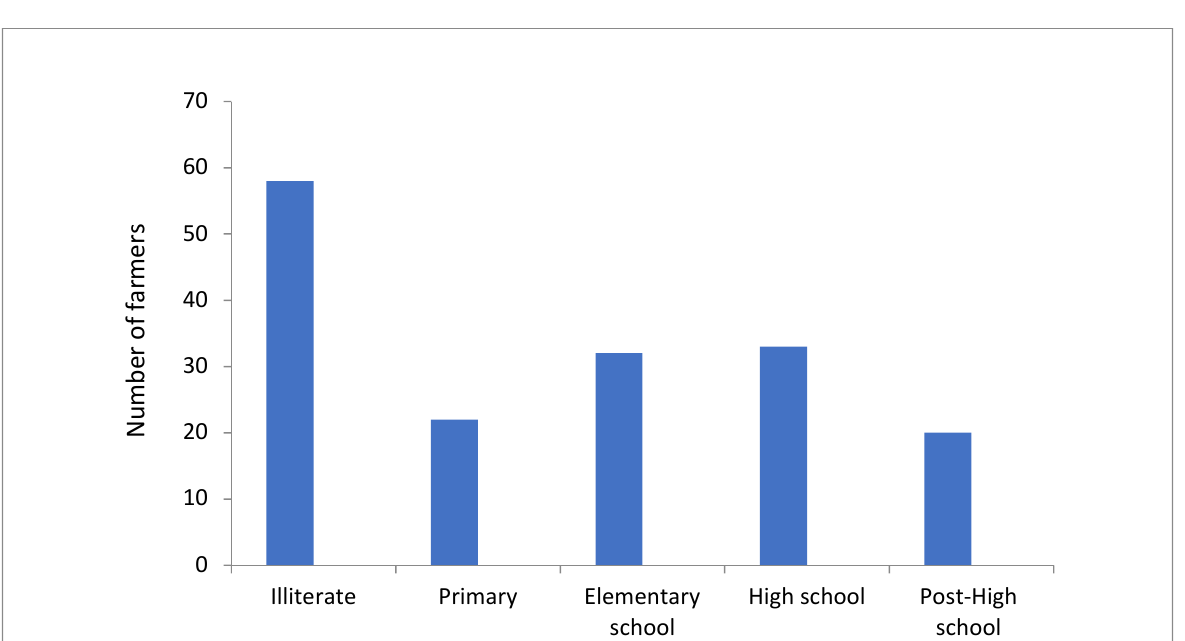
Table 1. Usefulness of electronic media (EM) as a source of information among dairy farmers.